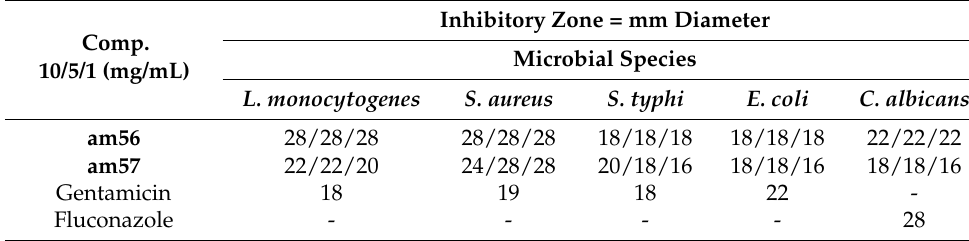
Table 26. Antimicrobial activity of the compounds ( am56 – am57 ).